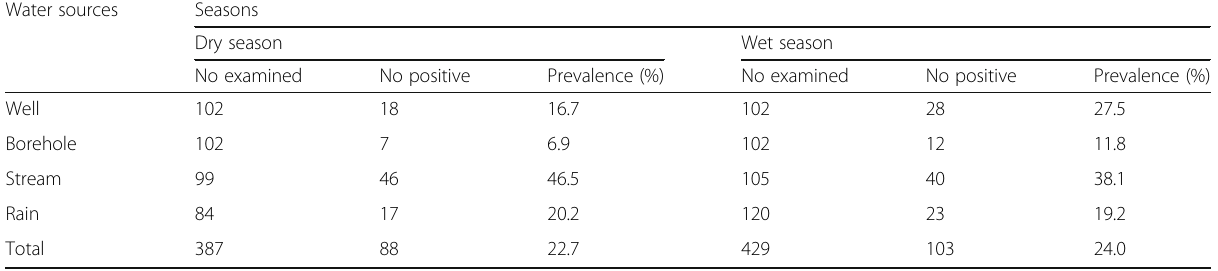
Table 4 Seasonal prevalence parasitic contamination of different water sources Water